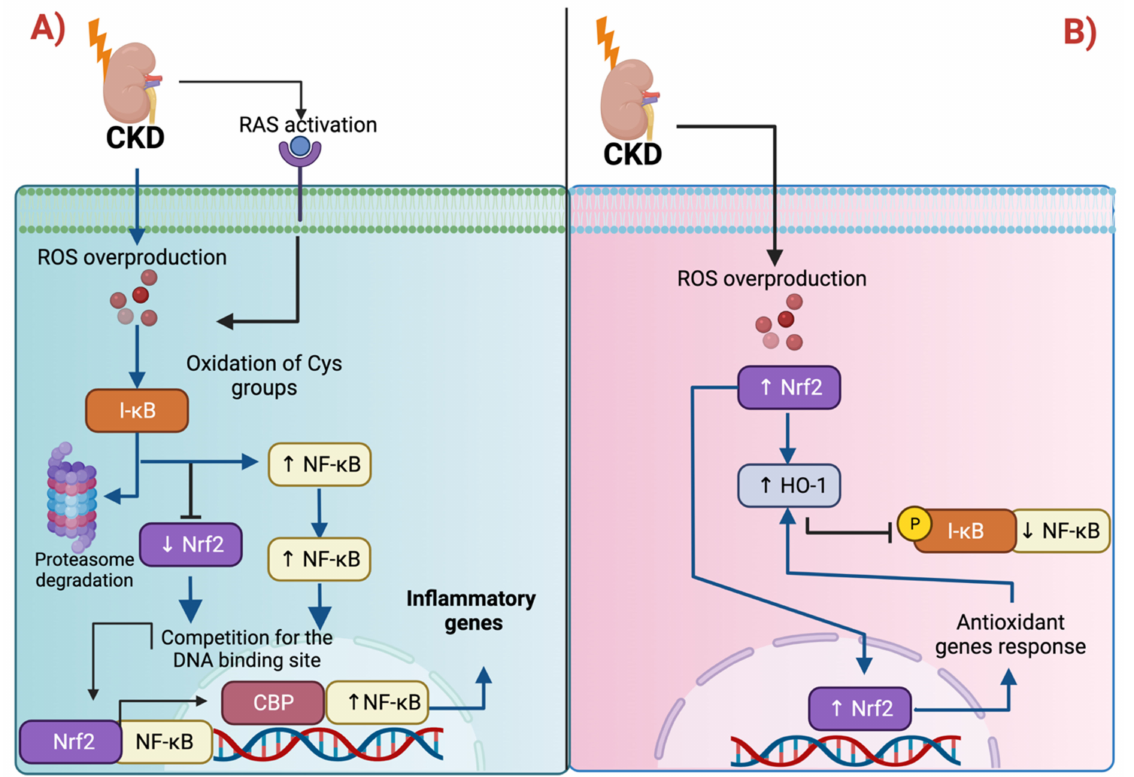
Figure 2. The nuclear factor erythroid 2-related factor 2 (Nrf2) regulates inflammation in chronic kidney disease (CKD). ( A ) The activation of the renin-angiotensin system (RAS) augments ROS production. This ROS oxidizes the cysteine (Cys) groups of the nuclear factor-kappa B (NF- κ B) inhibitor, I κ B, modifying and promoting its proteasome degradation. This triggers the release of NF- κ B, which competes with Nrf2 by the binding DNA site of CREB protein (CBP), ( B ) ROS overproduction also activates Nrf2, inducing its nuclear translocation. The latter upregulates heme oxygenase-1 (HO-1), avoiding NF- κ B activation by impeding I κ B phosphorylation. The figure was created using